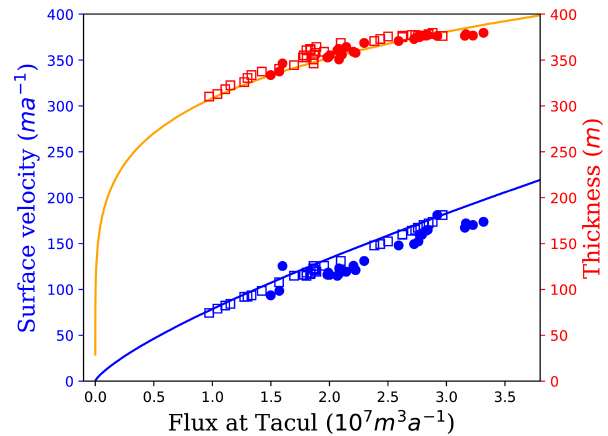
Figure 4. Surface velocity (blue) and thickness (red) at the Tacul gate as a function of the flux through the gate. The curves are the analytical solutions obtained using the SIA (Eq. 6), and the squares correspond to the flux integrated by Elmer/Ice using observed sur- face velocity, ice thickness and a velocity distribution given by Eqs. (4) and (5). The circles are the fluxes estimated by Berthier and Vincent